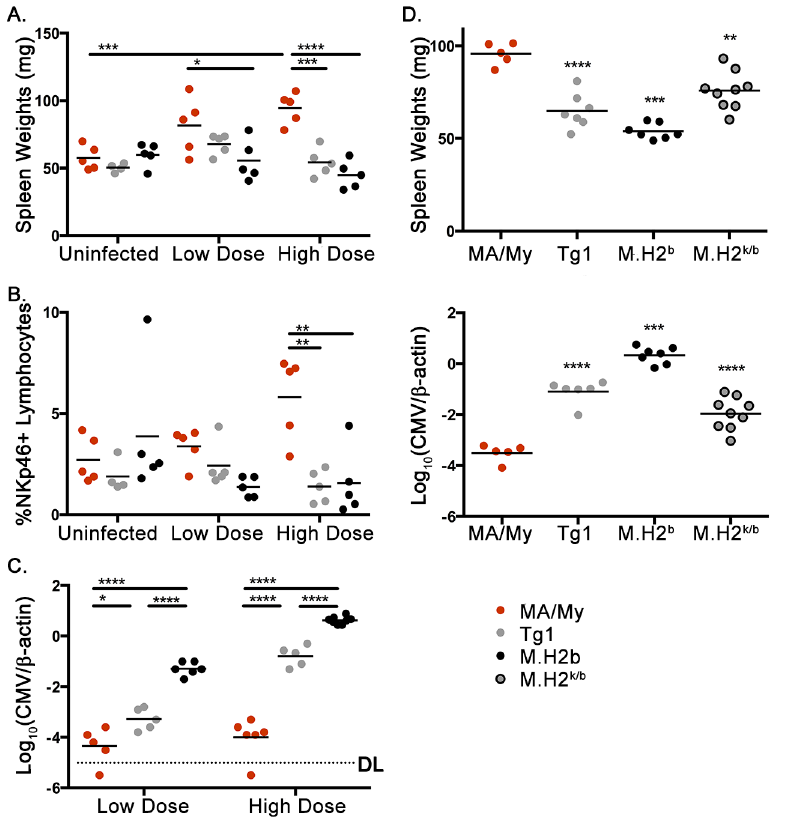
Fig 4. Verification of the Cmv5 locus on chr-17 in MA/My-related congenic strains. (A and B) The plots show spleen weights (A) and percentages of NKp46 + NK cells (B) in uninfected, and LD- and HD-infected MA/My, M.H2 b and Tg1 (M.H2 b background) mice. The data are representative of 3 independent experiments. (C) The plot shows MCMV genome levels detected in spleen DNAs obtained from the indicated mice. The data are representative of 3 independent experiments. (D) The plots show spleen weights (left) and MCMV genome levels (right) for uninfected and HD-infected MA/My, M.H2 b , Tg1 and (MA/My x M.H2 b )F 1 cross mice. The data are representative of 2 independent